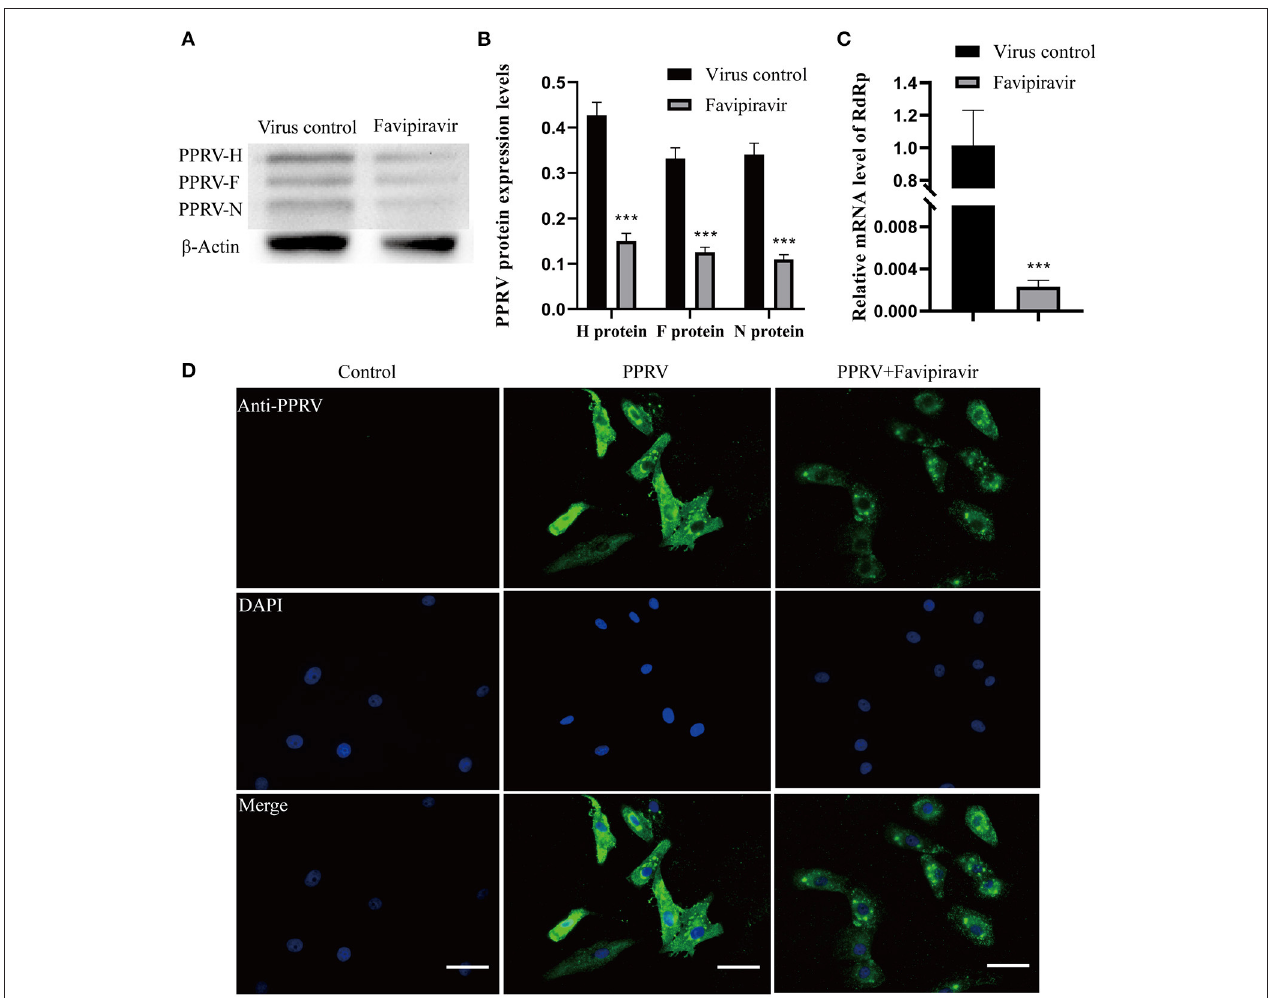
FIGURE 2 | The anti-peste des petits ruminants virus (anti-PPRV) effect of favipiravir in Vero cells. (A,B) Vero cells were treated with PPRV at 100 TCID 50 and favipiravir at 50 µ g/ml for 48h, following which the expression of the structural proteins H, F, and N was analyzed by Western blotting (*** p < 0.001 vs. the virus-only control). (C) Vero cells were treated with favipiravir and PPRV simultaneously for 48h, and then the relative mRNA expression levels of the H and N genes were measured by qRT-PCR (*** p < 0.001 vs. the virus-only control). (D) The anti-PPRV activity of favipiravir was detected by immunofluorescence assay (IFA) in PPRV-infected Vero cells after 48h. PPRV is in green; nuclei are stained blue (DAPI). Scale bars = 50 µ